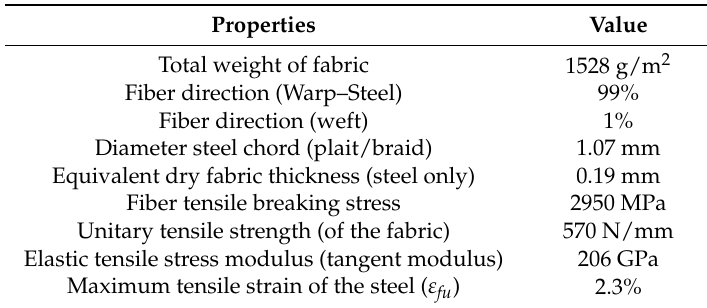
Table 2. Properties of the unidirectional steel